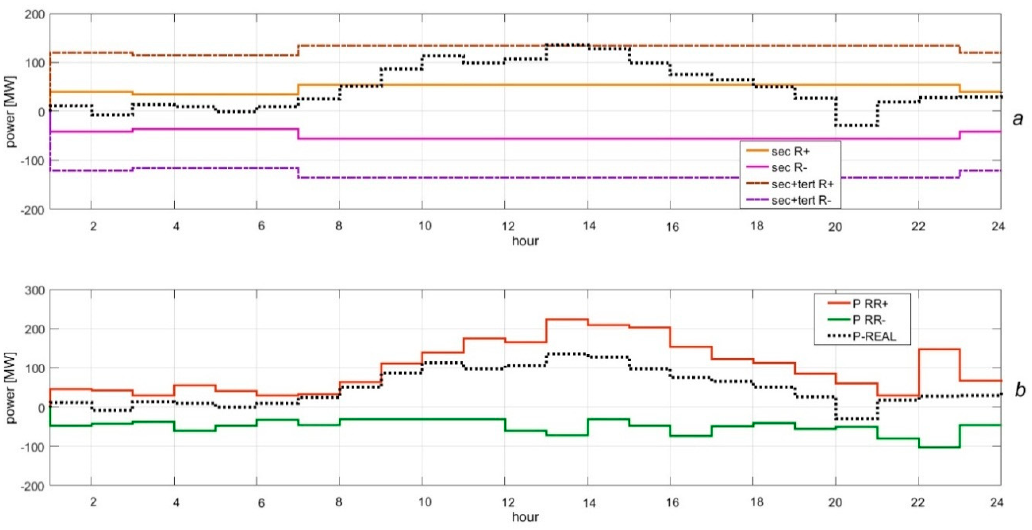
Figure 5. Reserve scheduling for April 15, 2015; ( a ) classic approach, ( b ) proposed approach.